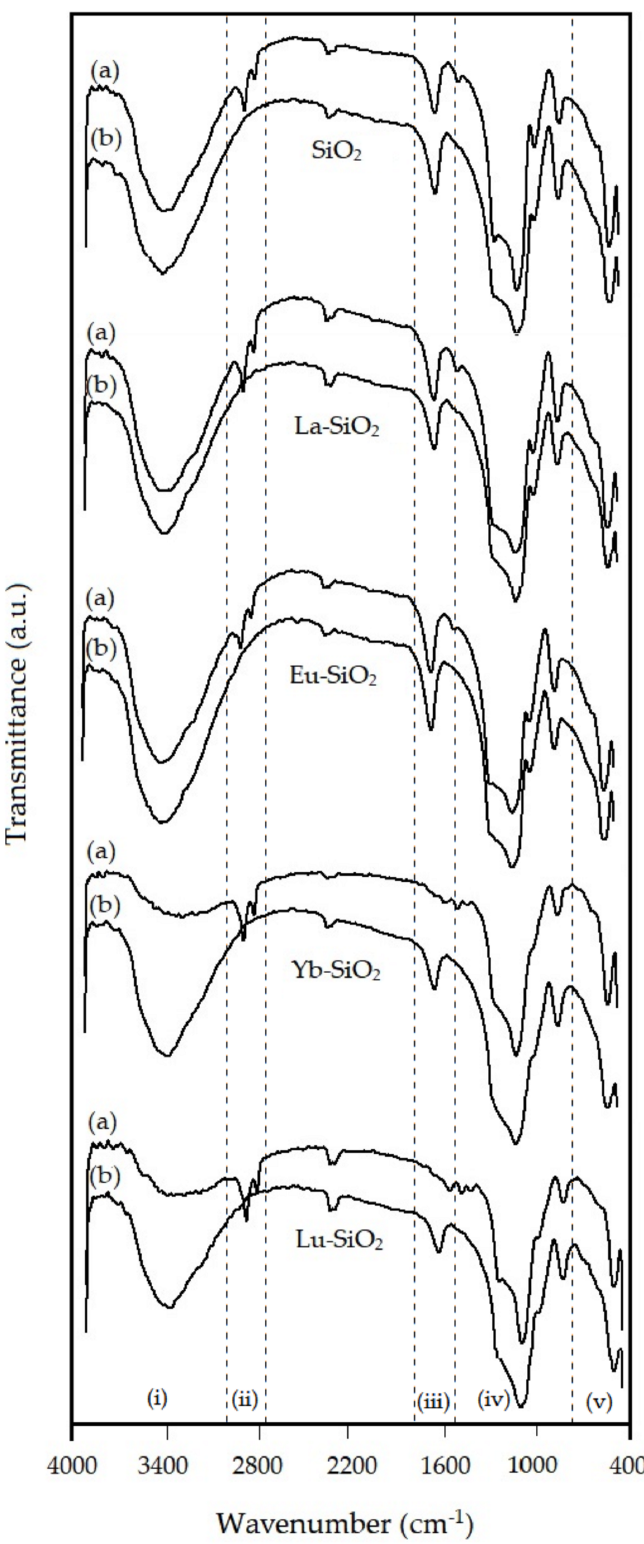
Figure 8. Fourier-Transform infrared spectra for SiO 2 and Ln–SiO 2 : (a) before calcination and (b) calcined samples.